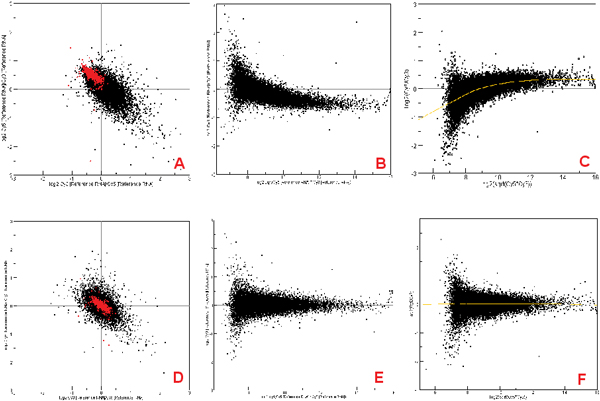
Experimentally observed anti-correlation of log ratios for dye-swap replicates. A: Anti-correlation of dye-swap replicates (self-self hybridizations) before Lowess normalization; B and C: MA plots for dye-swap pair before Lowess normalization; D: Correlation of dye-swap replicates after Lowess normalization; E and F: MA plots for dye-swap pair after Lowess normalization. Spots colored in red are of higher average intensity.